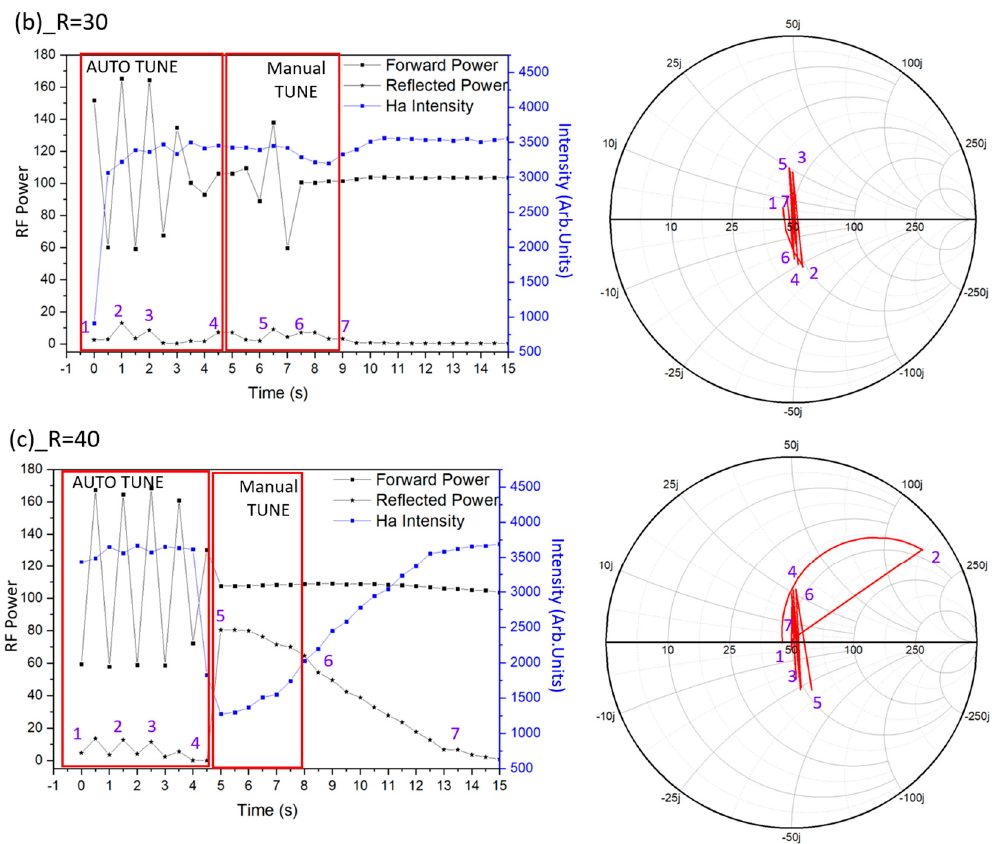
Figure 8. The automatic and manual tune results of RF power supply on the RF-positive power source: ( a ) R = 10; ( b ) R = 30; and ( c ) R = 40. Forward and reflected waveform of coupled RF power source (left) and associated Smith chart (right).